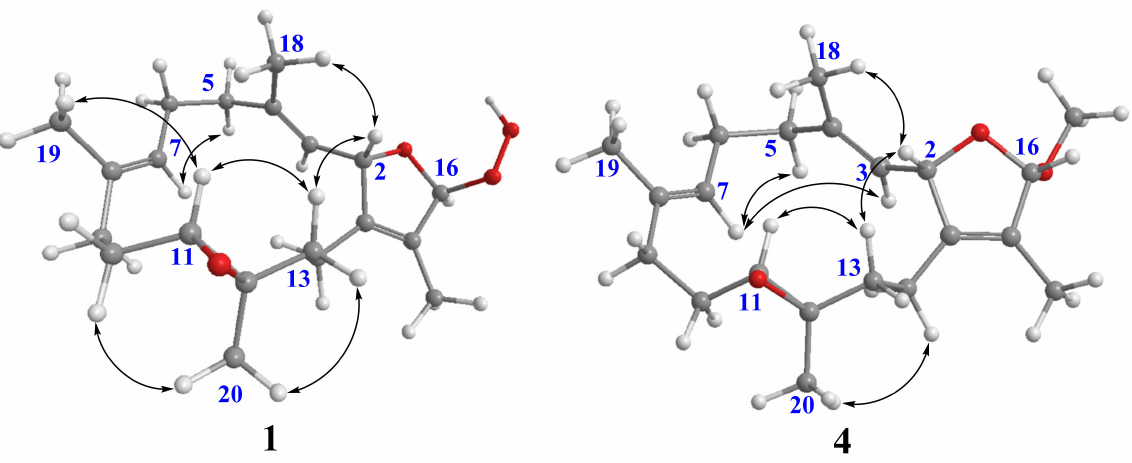
Figure 3. Selective NOE correlations of 1 and 4 .